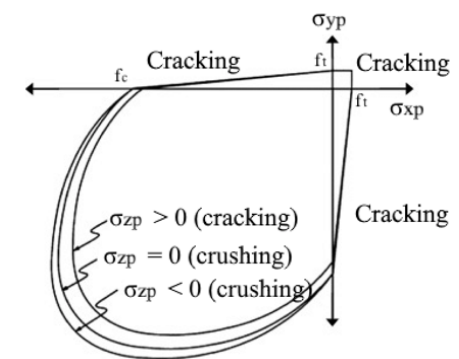
Figure 6. Constitutive model of concrete (adapted from ANSYS